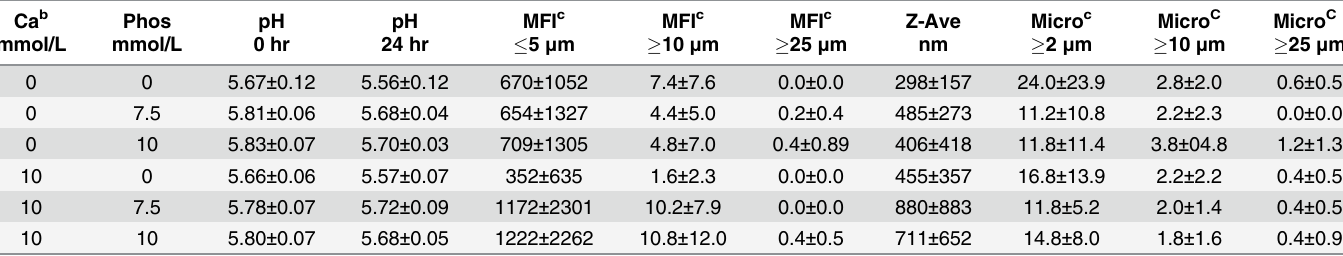
Table 5. Compatibility Studies for 2.5% TrophAmine Solutions a Containing CaCl 2 and Sodium Phosphate Without Added Cysteine (Mean ± SD).